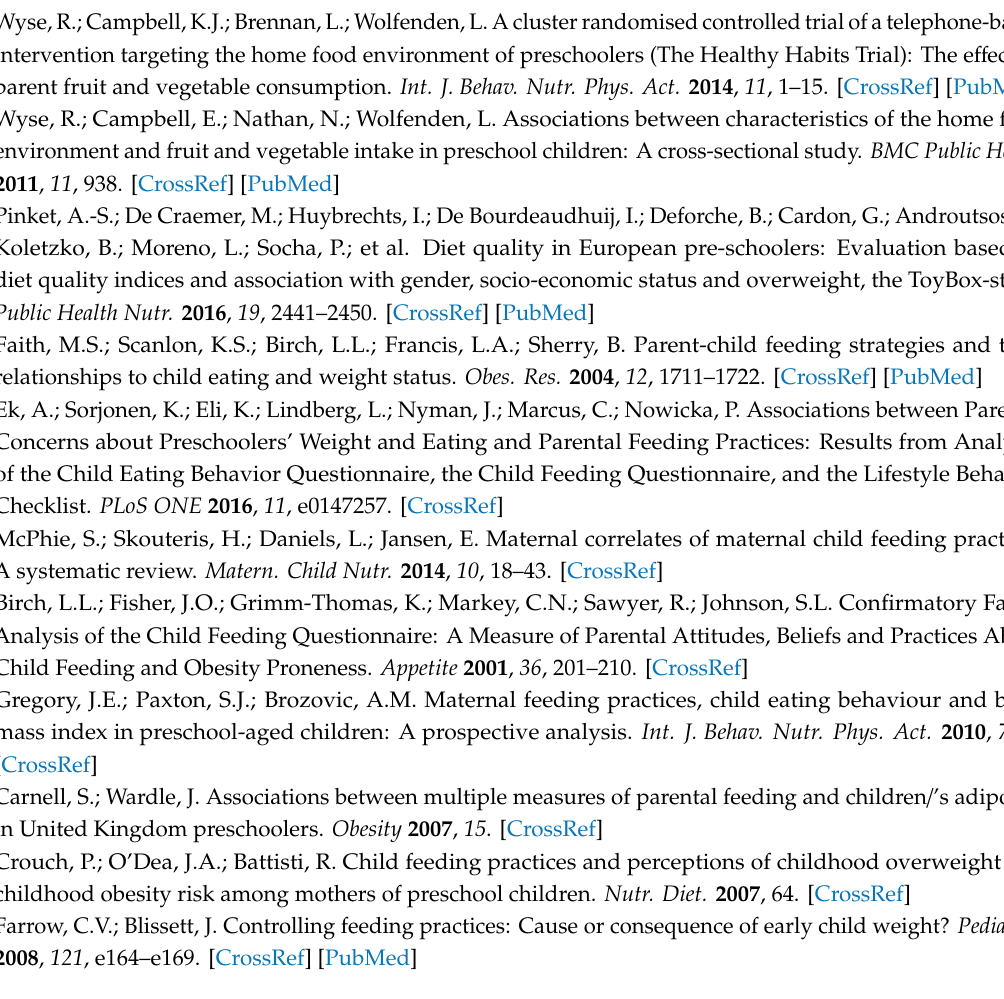
Figure S1: Parental control feeding practice by parents’ education level, Table S1: Participant and home environmental characteristics resulting as significant after bivariate analysis with children’s fruit intake, Table S2: Participant and home environmental characteristics resulting as significant after bivariate analysis with children’s vegetables intake, Table S3: Participant and home environmental characteristics resulting as significant after bivariate analysis with children’s confectionary / SSB